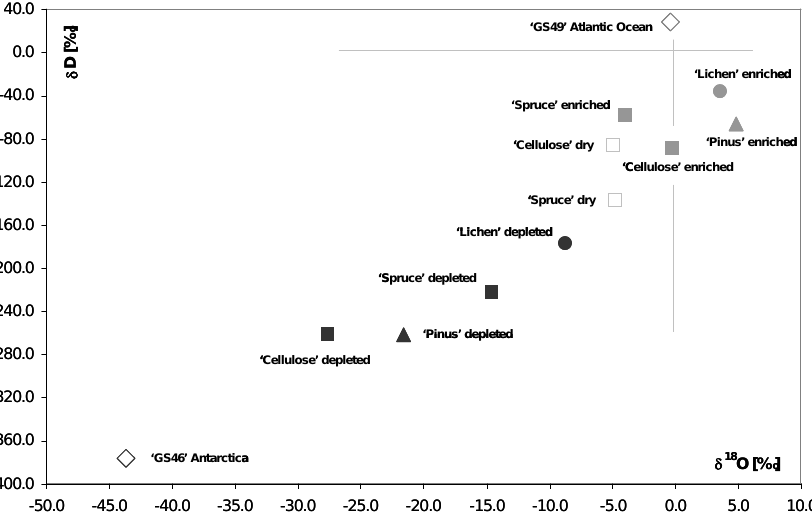
Fig. 8. Isotopic signature of the used water sources (open diamonds) and of the combustion-derived H 2 O from four different kinds of fuel (black symbols are samples wetted with the depleted water, grey ones with the enriched water). The open symbols refer to the dry substance. Values are given on the VSMOW